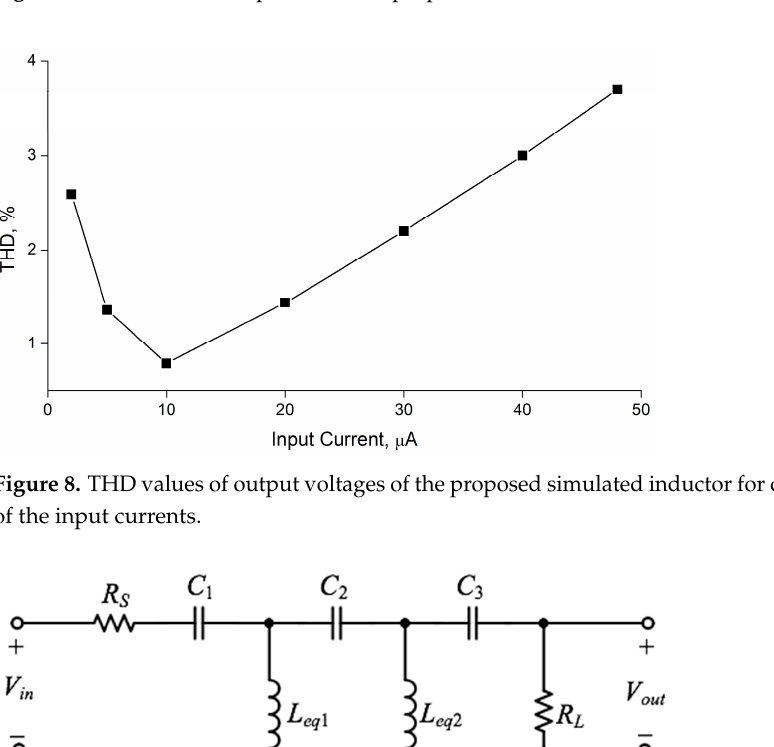
Figure 7. Time-domain responses of the proposed simulated inductor.